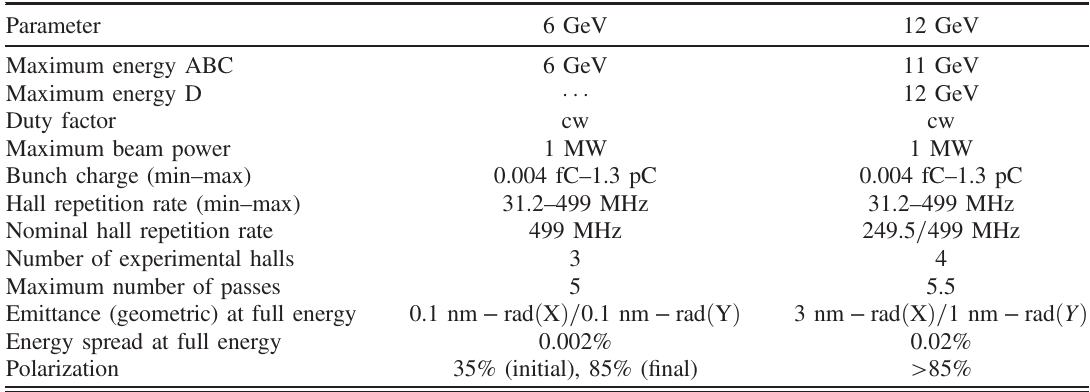
TABLE IV. Delivered beam parameters for 6 GeV CEBAF and expected beam parameters for 12 GeV CEBAF (reproduced from